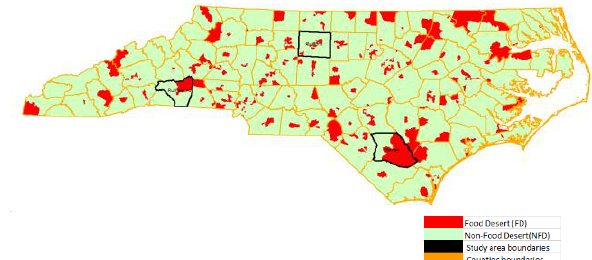
Figure 1. North Carolina food desert census tracts and study areas